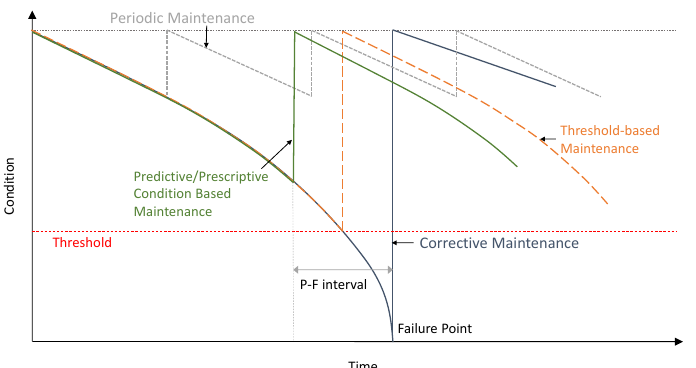
Figure 3. Turbine condition development for different types of maintenance strategies. Adapted from